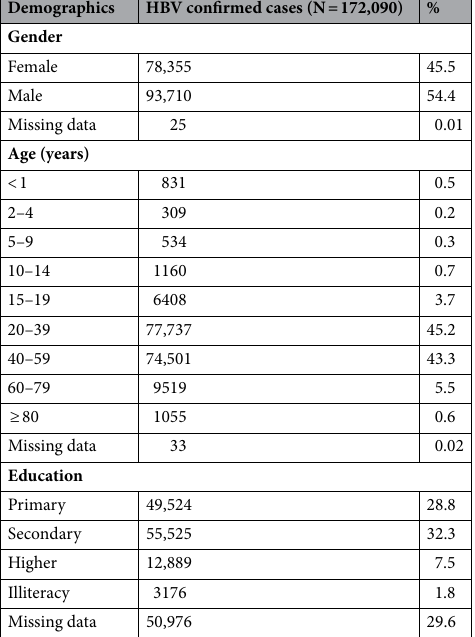
Presumptive source of